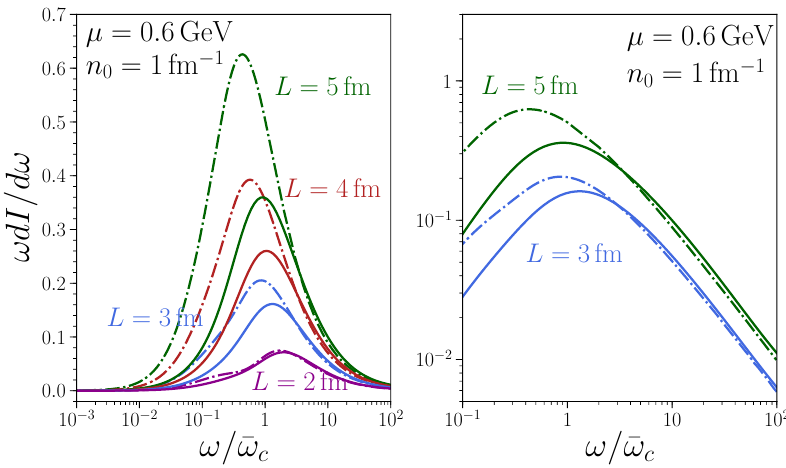
Figure 4 . Left: full medium-induced gluon energy distribution for the Yukawa-type interaction (solid lines) compared to the GLV (cid:12)rst opacity approximation (dash-dotted lines) with (cid:22) = 0 : 6 GeV and linear density n 0 = 1 fm (cid:0) 1 for di(cid:11)erent values of L as a function of the rescaled gluon energy != (cid:22) ! c . Right: same as left panel for only two values of L in log-log